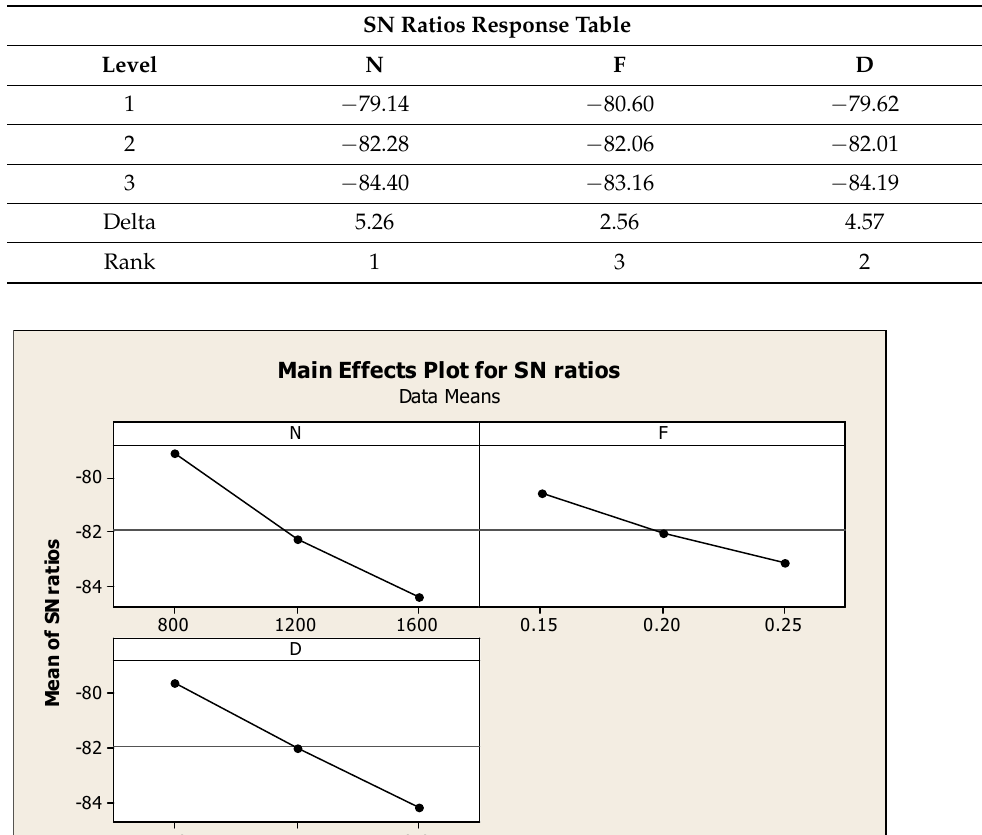
Table 8. Taguchi investigation details of MRR, SR, and CF vs. N, F, and D.